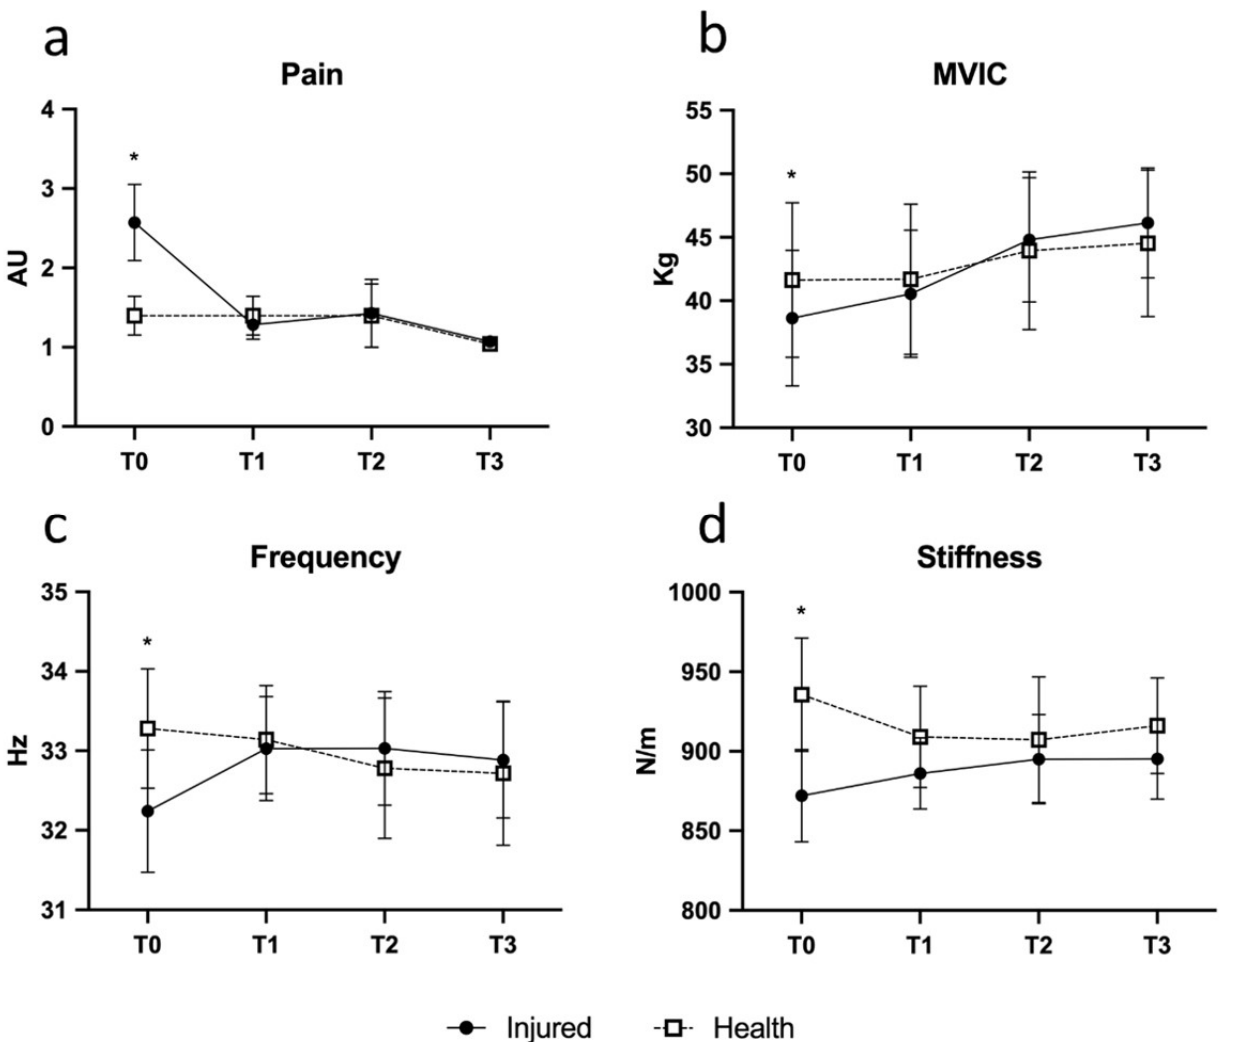
Figure 3. Time course variations of pain assessed with a 5-point Likert scale ( a ) (0 = no pain, 1 = low pain intensity, 2 = medium pain intensity, 3 = high pain intensity, and 4 = severe pain intensity), MVIC ( b ), frequency ( c ), and stiffness ( d ) in the Achilles tendinopathy (AT) (black dots) and contralateral healthy (white dots) tendon. Bars represent standard errors. * p < 0.05, intergroup comparison.